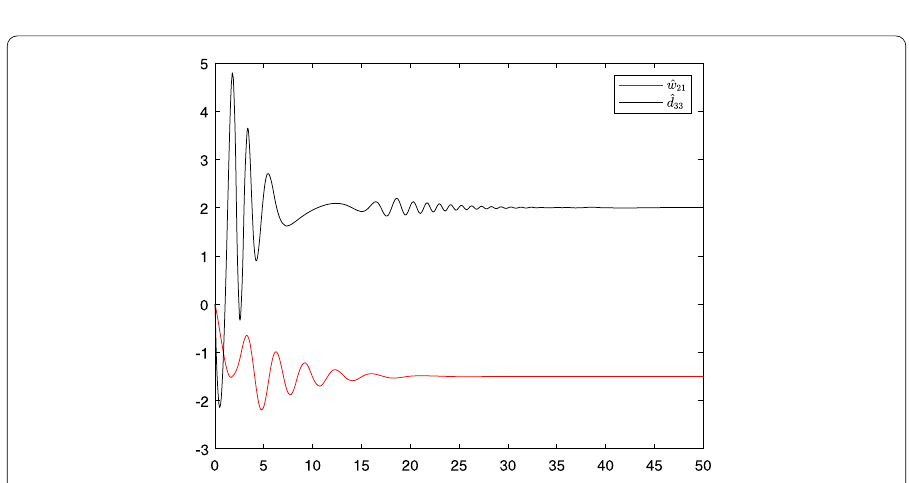
Figure 12 The temporal evolution of the estimated parameters ˆ w 21 and ˆ d